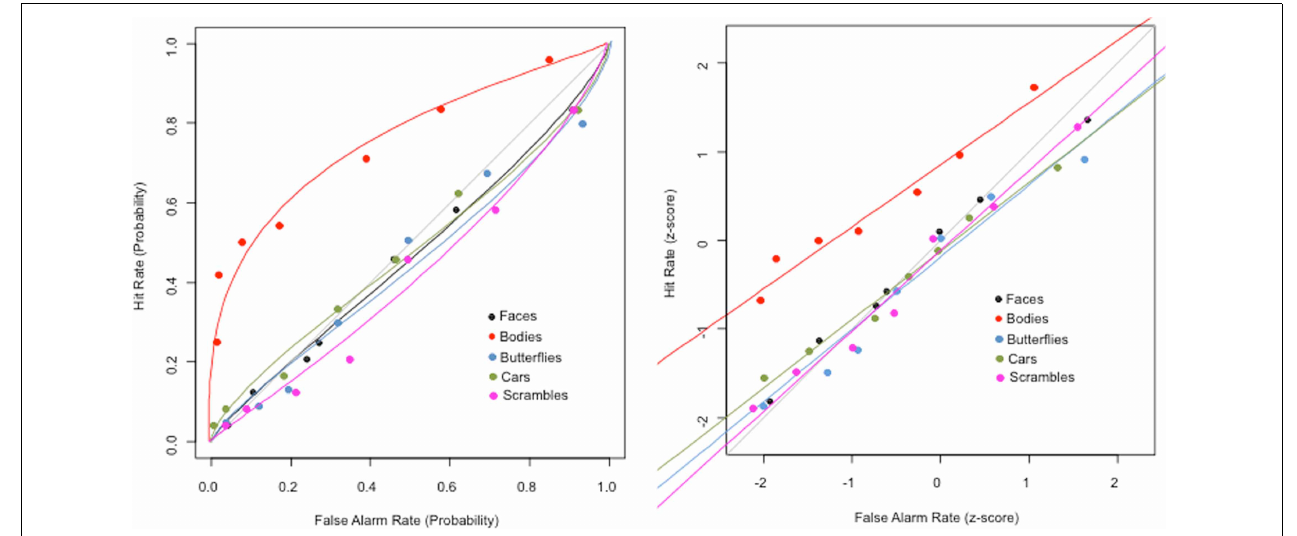
FIGURE 2 | Behavioral results. On the left, 7-points ROC curves are shown fitted to TN’s ratings as a function of the five stimulus categories reporting probability of hit rates vs. false alarm rates and on the right, Z-scores transformed ROC